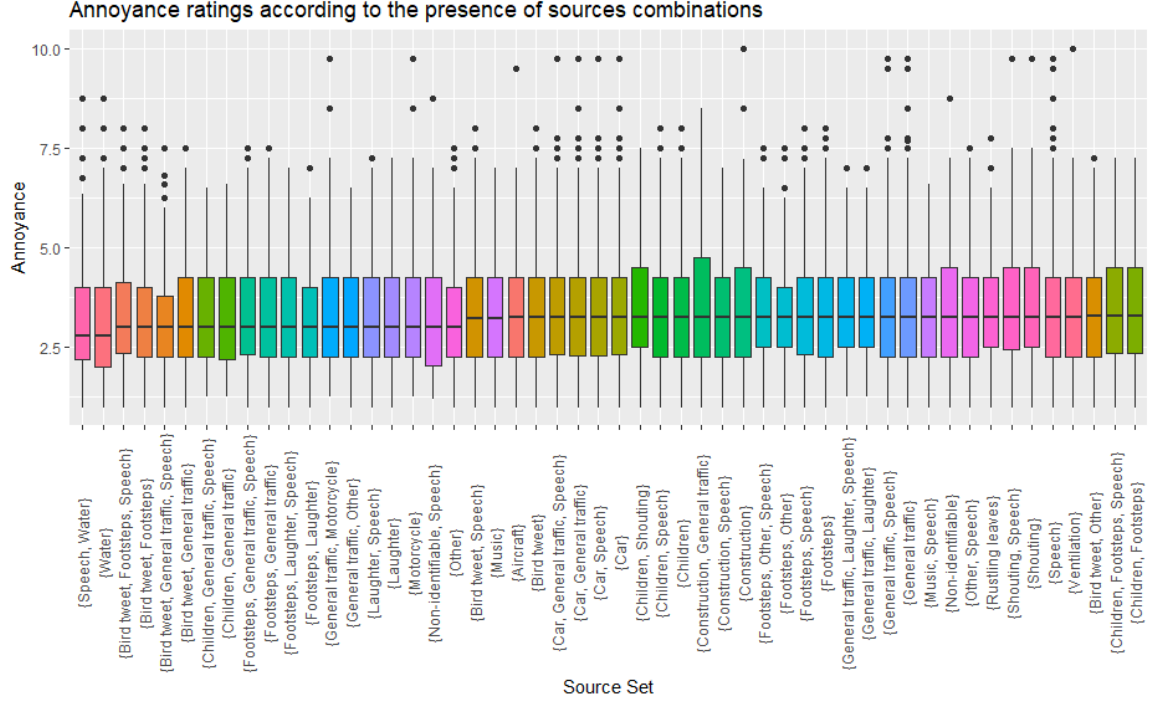
Figure 4. Box plots of the Annoyance scores for the recordings as a function of sound source present (including the “other” and “non ‐ identifiable” labels) and sources likely to be present together in the same recording as per the association rule